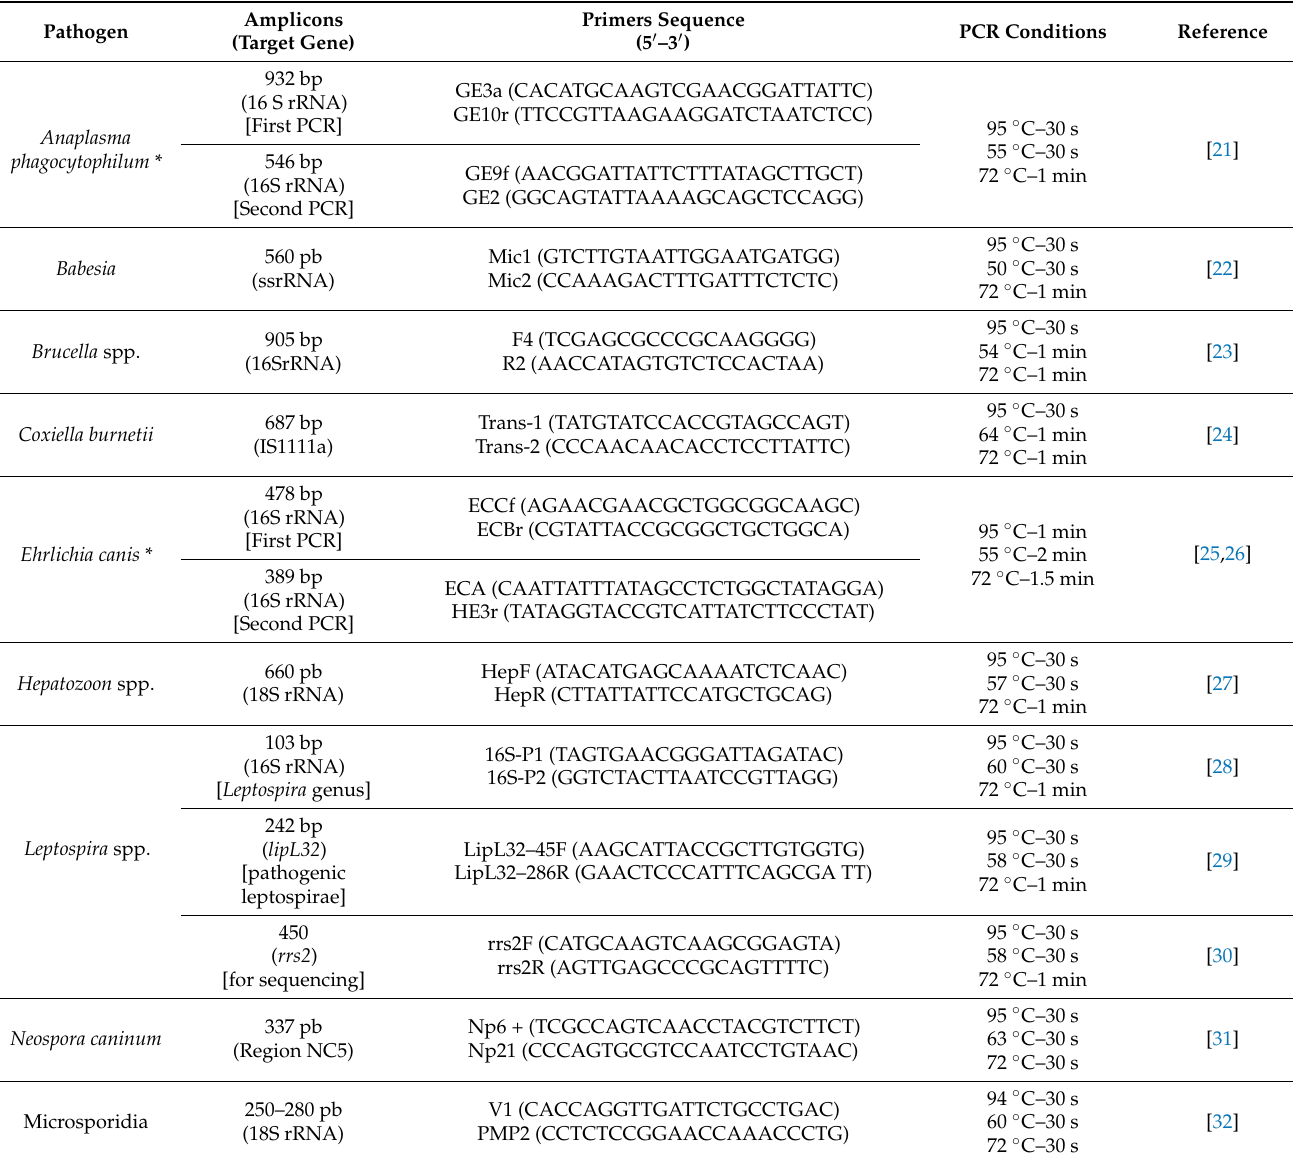
Table 1. PCR primers and conditions employed in the assays for the detection of each